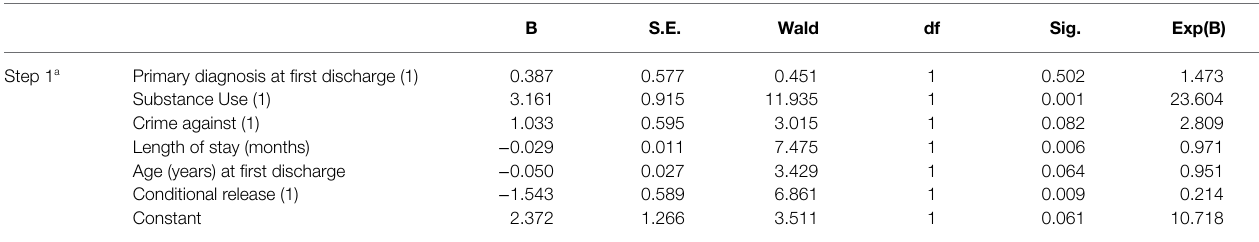
B S.E. Wald df Sig. Exp(B)